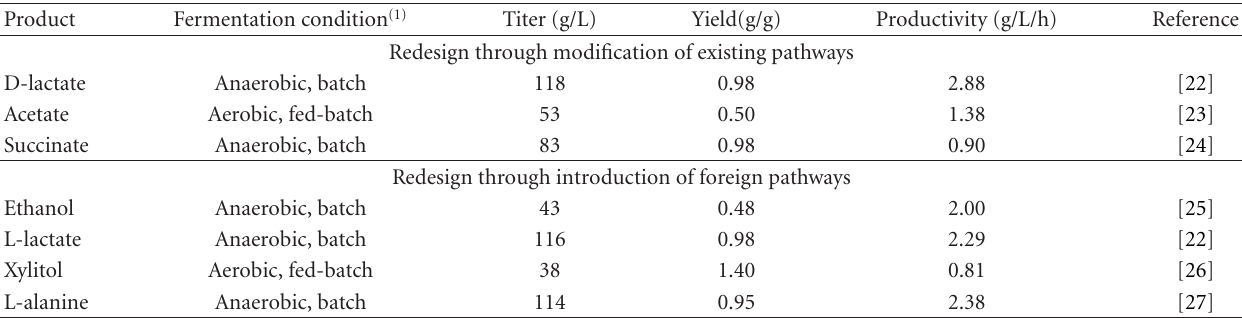
Table 1: Summary of engineered E. coli biocatalysts for production of renewable fuels and chemicals in our laboratory.